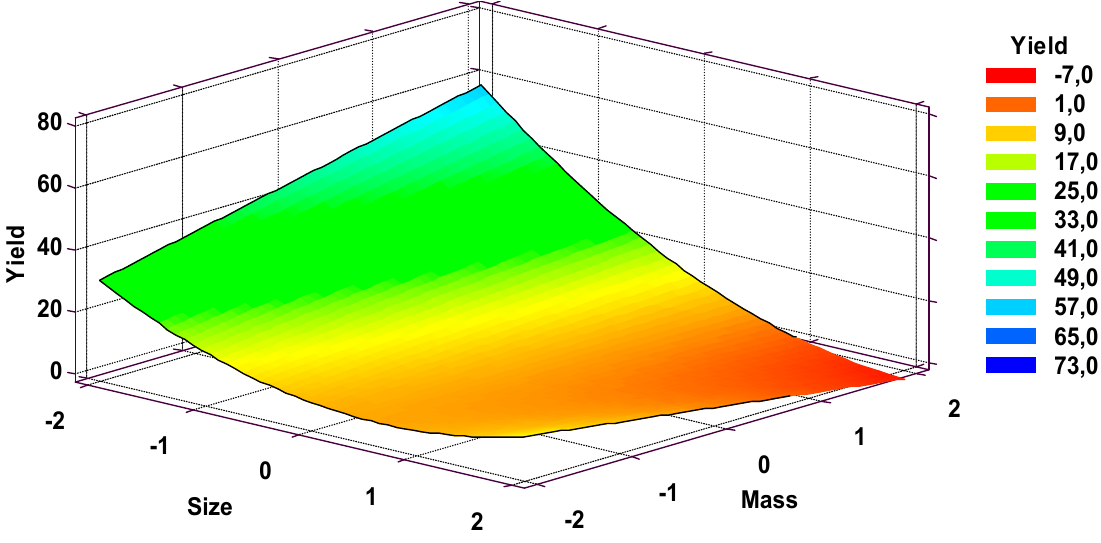
Figure 5. Obtained response surface for extraction